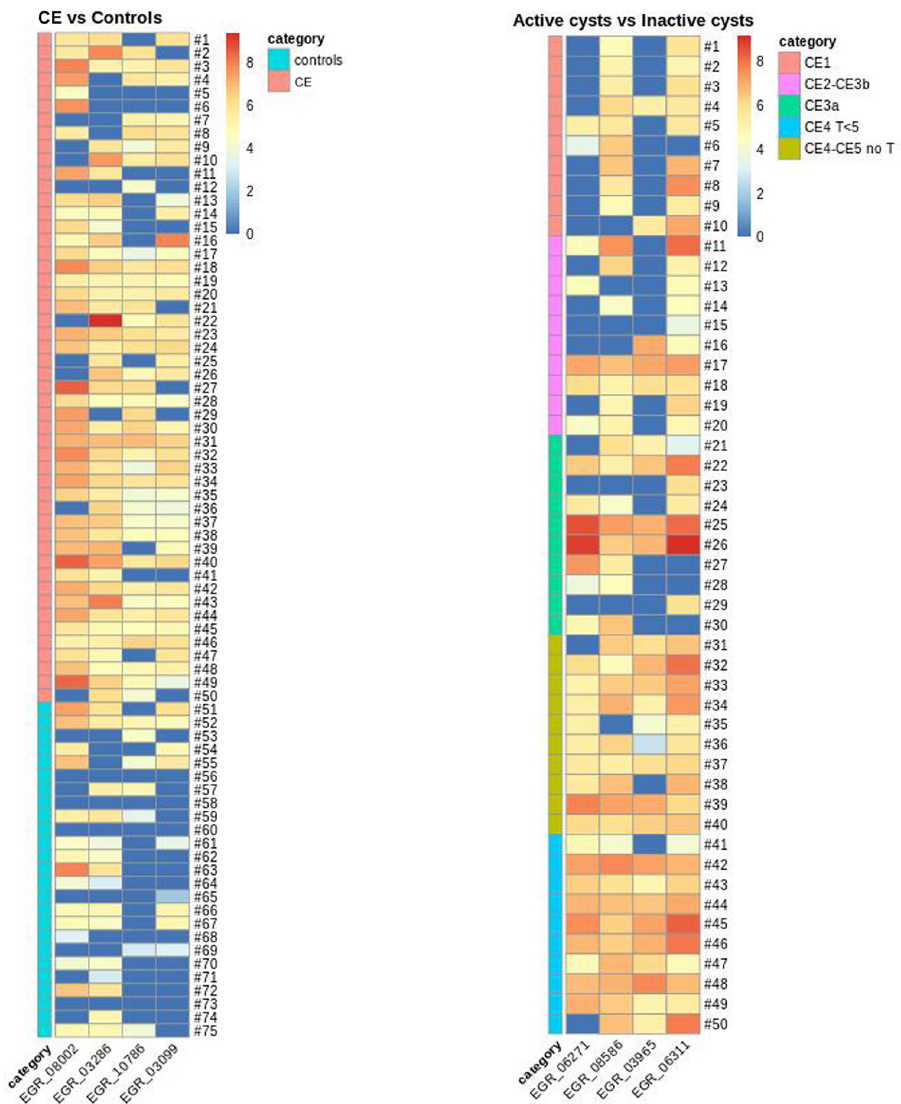
Fig 3. Heatmaps representing the spot intensities of peptide microarray for the selected peptides comparing CE patients and controls or active and inactive CE cysts. Left panel . Spot intensities were analyzed comparing CE patients (n = 50) and controls (n = 25) from the screening cohort. Right panel . Spot intensities were analyzed within CE patients only comparing patients with active cysts (n = 30) and patients with inactive CE cysts (n = 20) from the screening cohort. Footnotes: CE, cystic